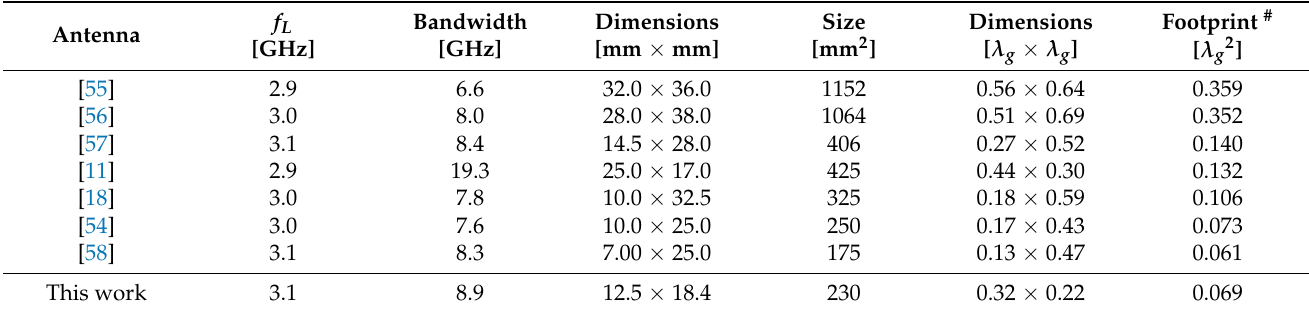
One should emphasize that the dimensions of the smallest Pareto-optimal antenna design were only 12.5 mm × 18.4 mm (footprint = 230.4 mm 2 ). The structure was com- pared against other compact UWB monopoles from the literature in terms of size and bandwidth. For the sake of fair comparison, the dimensions of the considered structures were expressed in terms of the guided wavelength λ g calculated for the lower corner fre- quency and the electrical performance of the substrates on which the considered radiators were implemented. The results gathered in Table 2 indicate that the proposed structure was characterized by a competitive size while providing acceptable performance. Small dimensions make the design’s potential use not only for a range of mobile UWB sensors and IoT-based localization services, but also for body of area network applications [54]. Table 2. Spline-parameterized antenna ( x 1.20* ) in comparison with the benchmark designs.